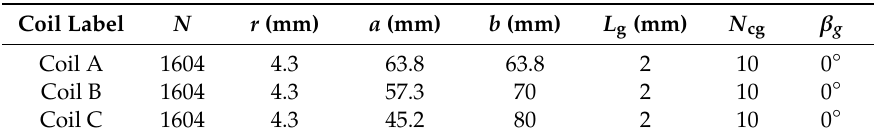
Figure 6. Experimental platform. ( a ) Schematic diagram; ( b ) power supply and the resistor; ( c ) experimental equipment in the laboratory environment. Table 1. Parameters of the three test coils.